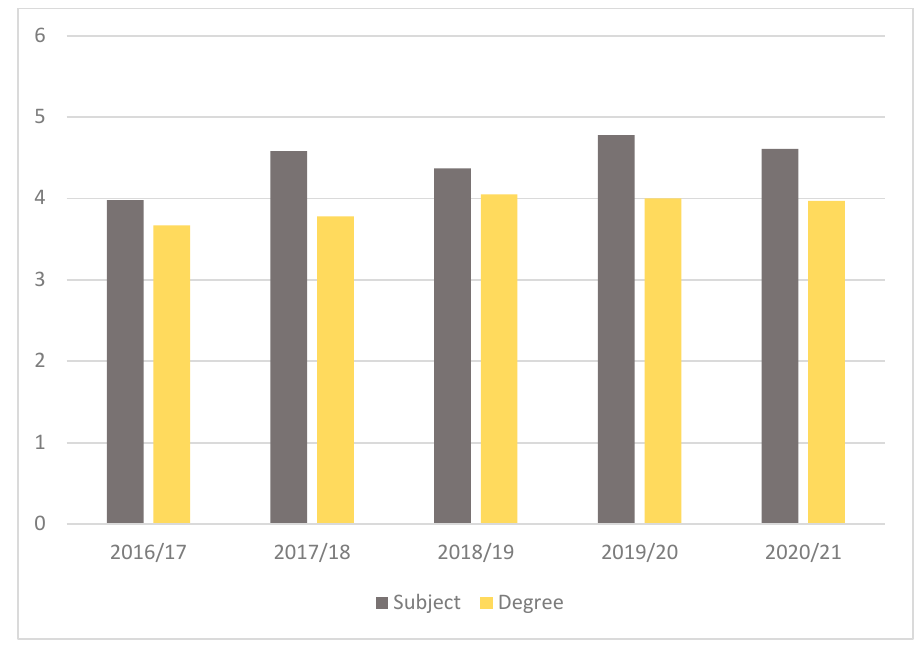
Figure 1. Results of the subject vs. results of the degree.